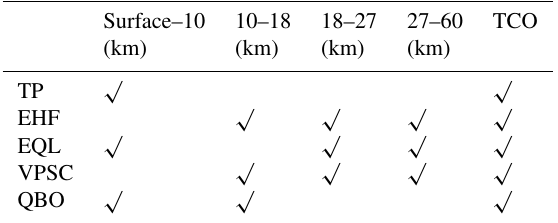
Table 4. The important drivers of ozone variations for each atmo- spheric layer and for total column ozone (TCO). The drivers are tropopause pressure (TP), eddy heat flux (EHF), equivalent latitude (EQL), volume of polar stratospheric clouds (VPSC), and the quasi- biennial oscillation (QBO). The EQL at 370K is used for surface to 10km, and the EQL at 550K is used for the middle and upper